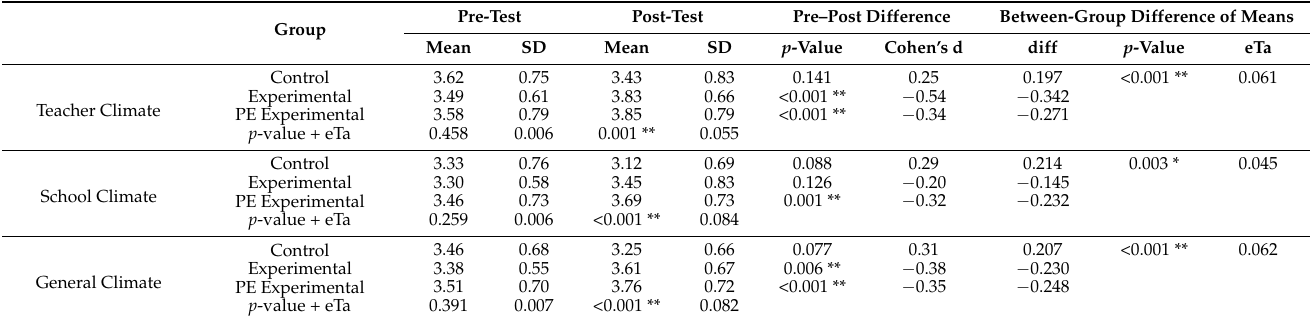
Table 6. Social school climate results.